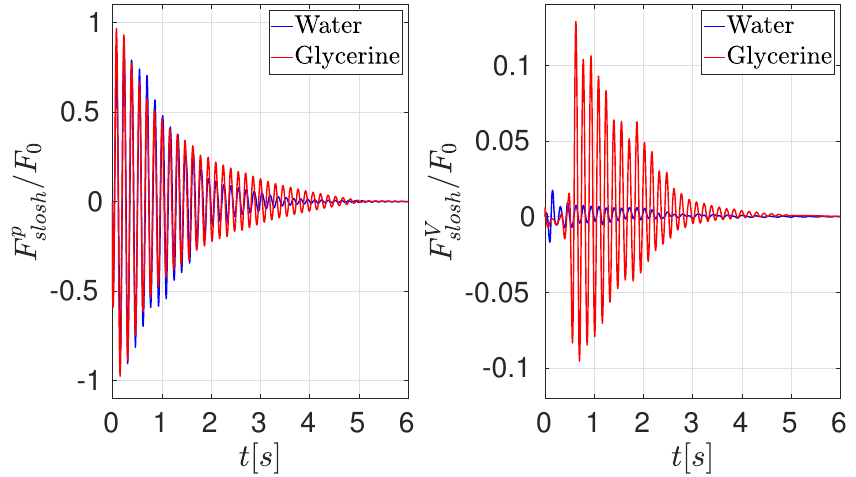
Figure 16. Nondimensional sloshing force components separated into their pressure and viscous contributions, for both the water and the glycerine